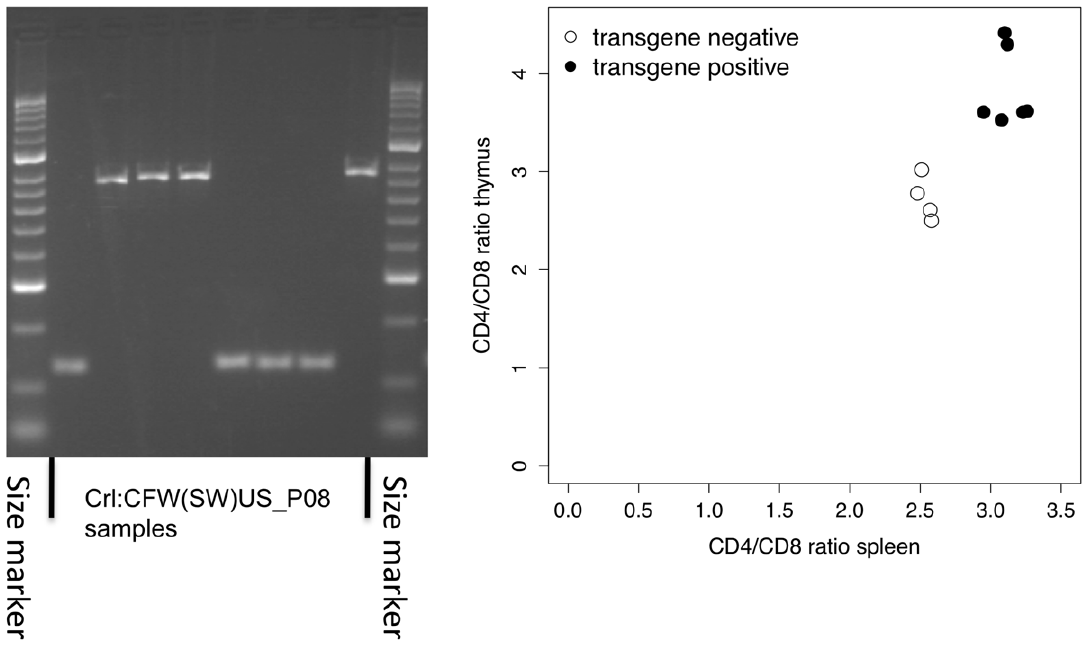
Figure 6. A deletion in the promoter of the alpha chain of the MHC class II E ab heterodimer contributes to variation in the ratio of CD4 + to CD8 + T-lymphocytes. On the left is shown PCR analysis of eight outbred mice demonstrating the presence of the deletion in the colony: smaller bands on the gel indicate animals with a homozygous deletion. On the right is shown the results of complementation with a transgene; the proportion of CD4 + and CD8 + cells was measured by flow cytometry in CD3 + splenocytes and CD3hi single-positive thymocytes of Eanull inbred NOD mice carrying the Ea16 complementing transgene (filled circles) or transgene-negative littermates (open circles).